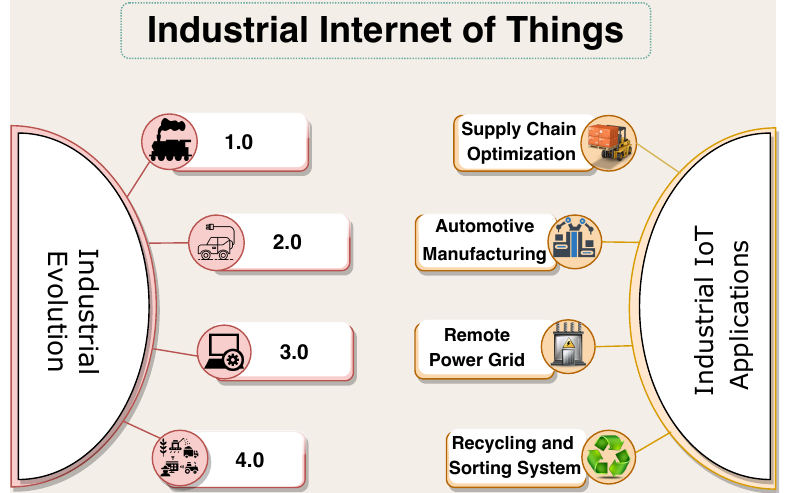
Figure 1. Industrial transformation and various applications of Industrial Internet of Things